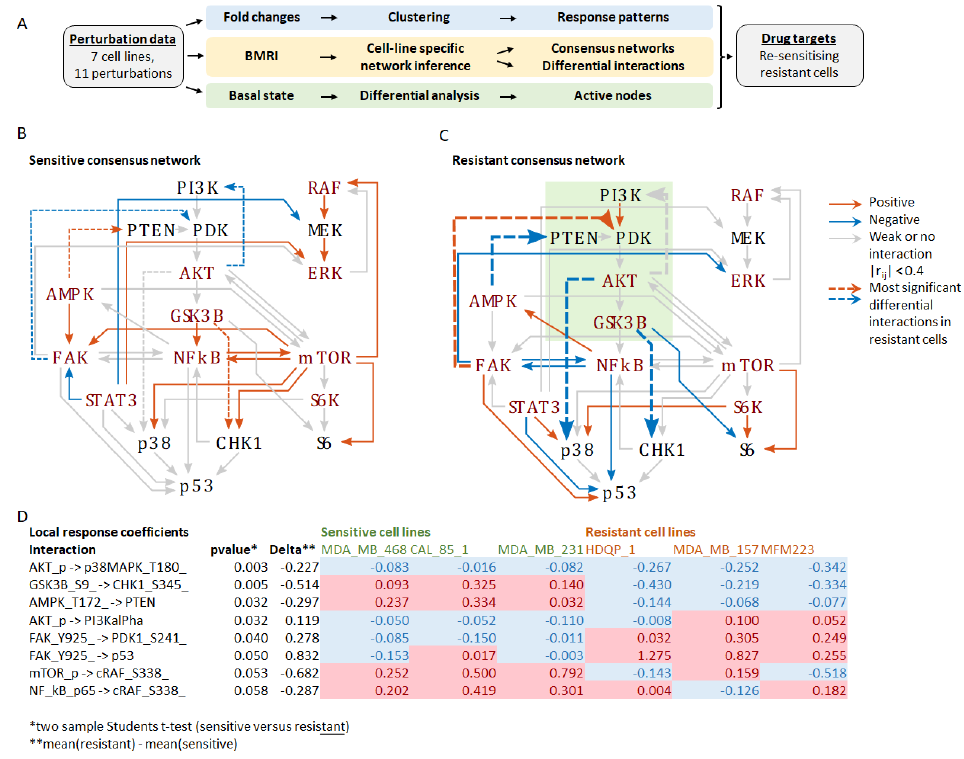
Figure 1. Inferred networks based on the perturbation experiments. ( A ) Schematic overview of the workflow depicting the three analyses performed: (1) Fold-change analysis in response to the treatments, (2) BMRI: Bayesian modular response analysis for network reconstruction, (3) Differential analysis of the basal (untreated) network state to identify the most active nodes in resistant versus sensitive cell lines. ( B ) Consensus network of the sensitive cell lines. ( C ) Consensus network of the resistant cell lines. Edges represent the BMRA-inferred network interactions (from Supplementary Figure S2) averaged over the sensitive and resistant cell lines as indicated in the legend. Strong interactions with local response coefficients greater that 0.4 are indicated with blue (negative) and red (positive) solid lines. Dashed lines indicate the most significant differential interactions in resistant cell lines (see ( D )). The green box indicates the PI3K-AKT signalling axis. ( D ) Table of the most significant interaction differences between sensitive and resistant cell lines. Negative values shaded blue indicate inhibition; positive values shaded red indicate